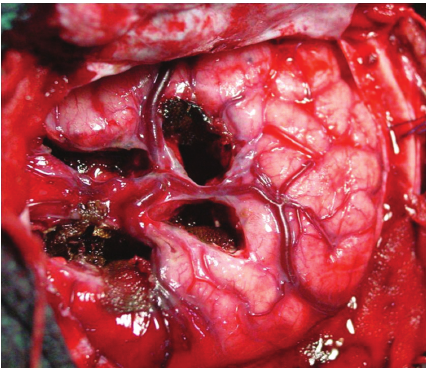
Figure 1: Intraoperative photograph of peri-insular hemisphero- tomy (PIH) showing the supra- and infrainsular windows.